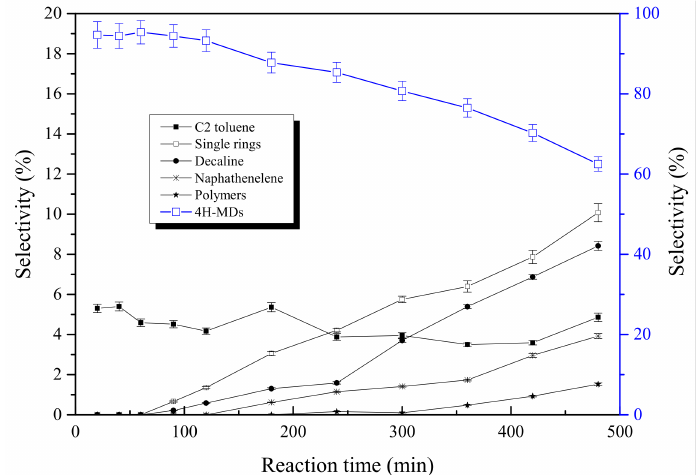
Figure 10. Distribution of 1-MN hydrogenated products with time on stream over CoMo/AZ (reaction conditions: the same as the conditions in Figure